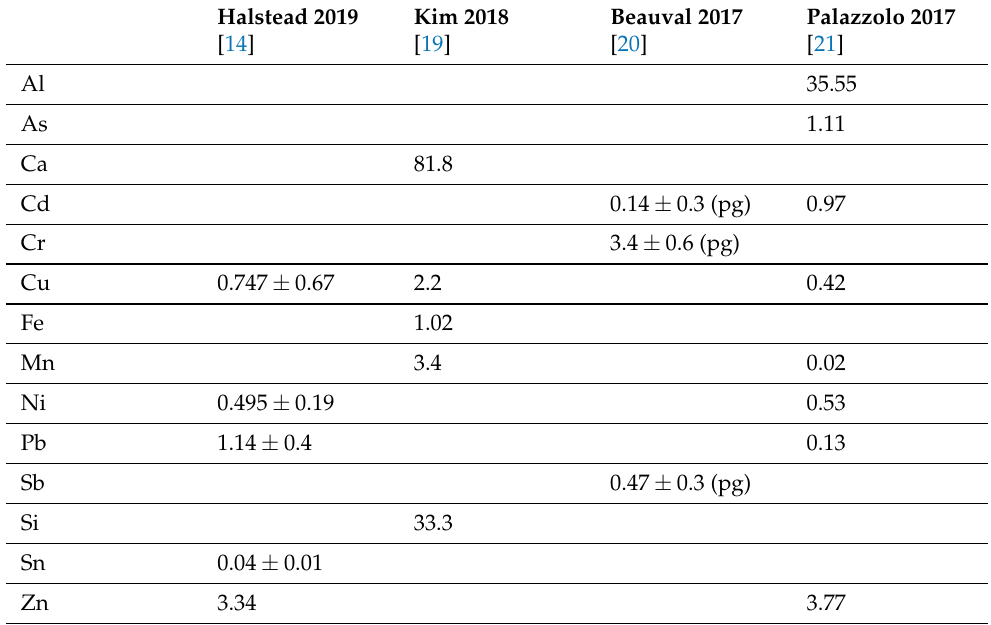
Table 11. Metal elements in other studies (outputs converted in ng/puff). Kim et al. [19] tested a third generation sub-ohm tank device, the rest tested second generation devices. The values for Beauval et al. [20] are in